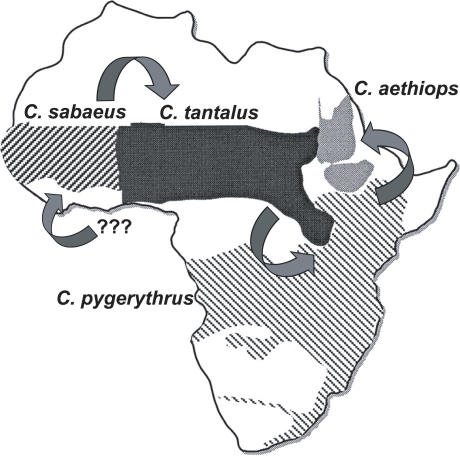
Hypothesized SIVagm Transmission Pattern across sub-Saharan AfricaAGM distributions across the African continent are depicted. According to SIVagm phylogenetic analysis, C. sabaeus was the first AGM to be infected with SIV, although the source of this infection is unknown. The arrows depict a possible route of transmission of the virus across already established AGM ranges. It should be noted that the inferred SIVagm phylogeny does not distinguish between the depicted route of transmission and a route in which C. tantalus first infected C. aethiops, which in turn infected C. pygerythrus. This figure is modified from Beer et al. [64], which utilized the range map from Lernould [12].